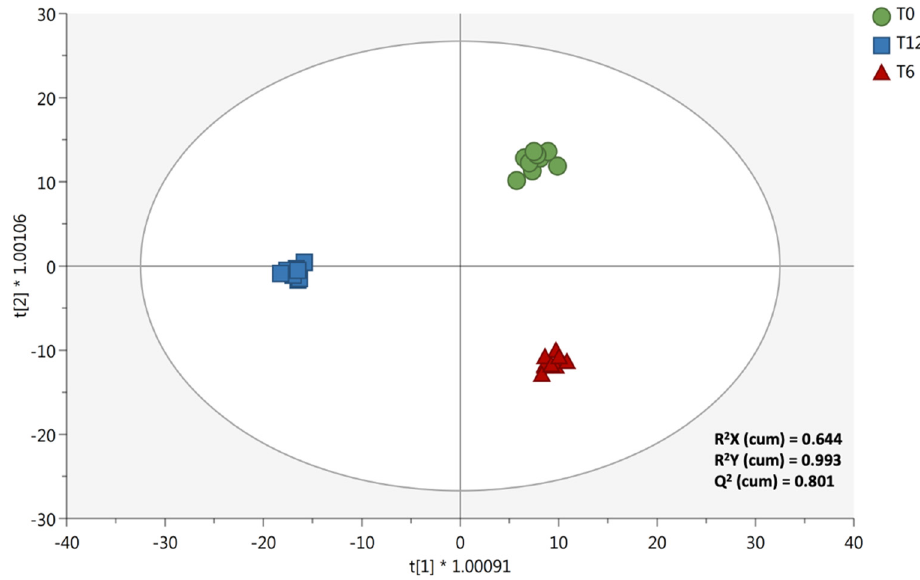
Figure 5. Supervised OPLS-DA score plot built considering the shelf-life period of the ricotta samples as class discrimination parameter.